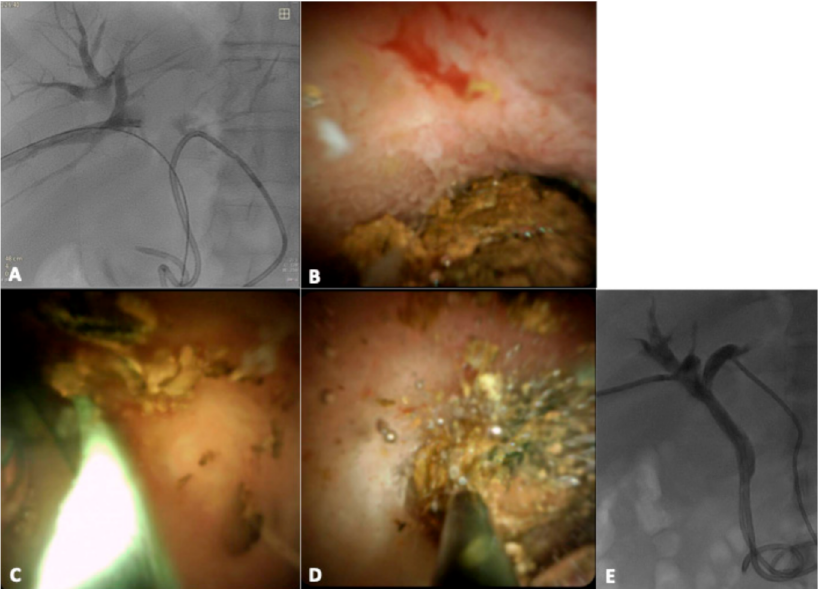
Figure 2. Percutaneous approach of the spyglass ( A ); intra-ductal visualization of the stone ( B ); intra-procedural lithotripsy ( C ) and wash with saline ( D ); cholangiography performed 3 days after percutaneous transhepatic lithotripsy (PTL) reveals absence of filling defects ( E ).